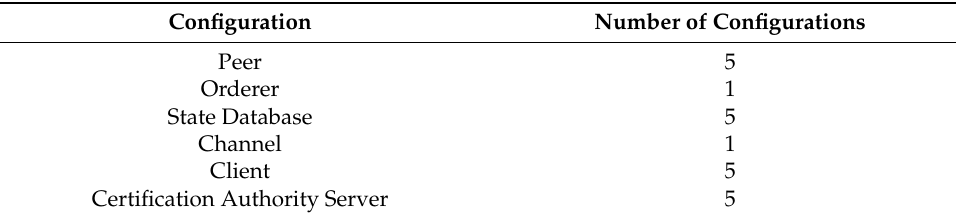
Table 4. System configuration of the two-level blockchain system for the